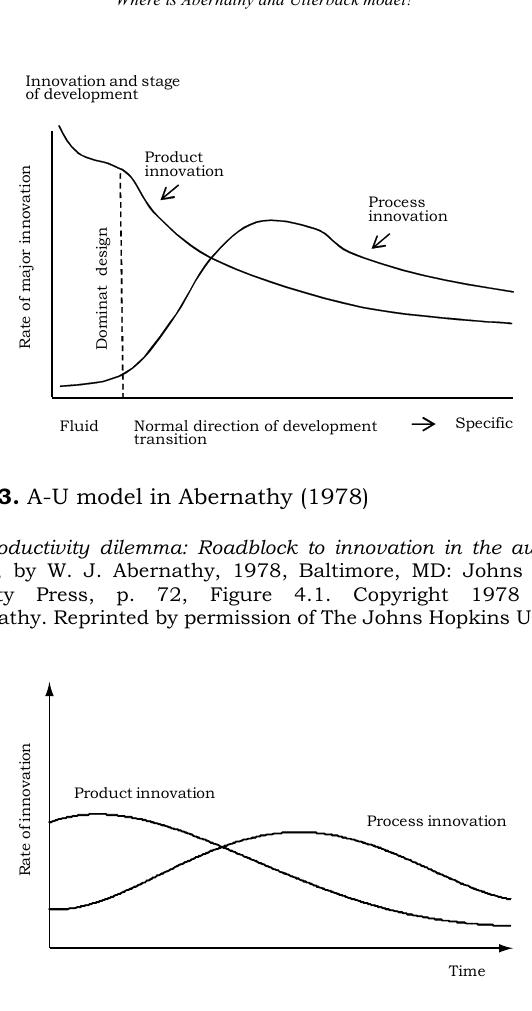
Figure 4. A-U model in Adner and Levinthal